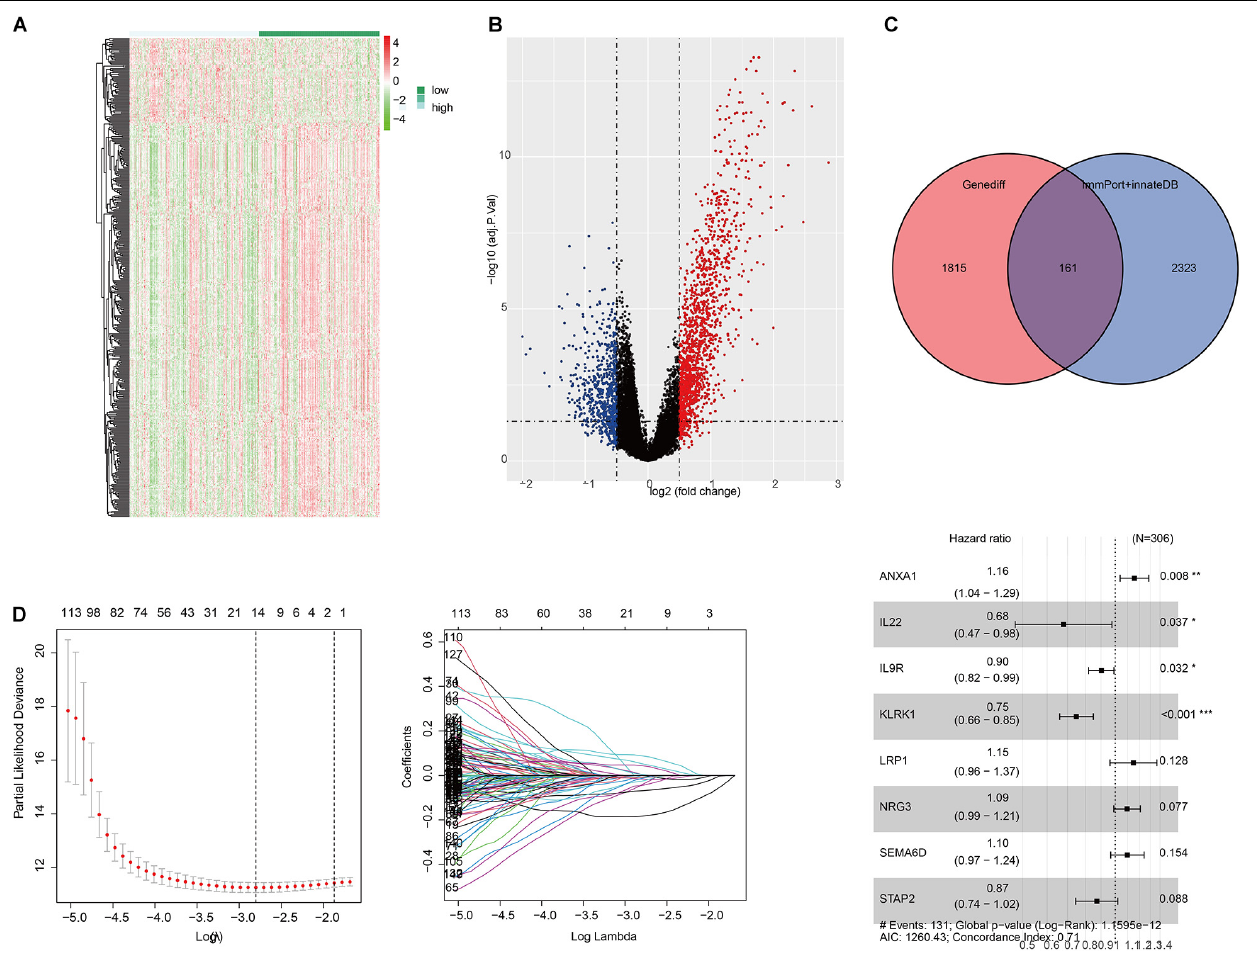
FIGURE 2 | Selection of differentially expressed immunity genes (DEIGs) and establishment of immune-related risk models. (A) Heatmap of all differentially expressed genes (DEGs) in the immunity low group and immunity high group. (B) Volcano plot of all DEGs showing the log 2 fold change and q value of each DEG. (C) Venn diagram of DEGs showing immune-related gene set obtained from ImmPort and InnateDB. (D) LASSO coefficient distribution map, prognostic biomarker selection characteristics, and forest plot based on multivariable Cox proportional hazards regression. * p < 0.05, ** p < 0.01, *** p < 0.001.